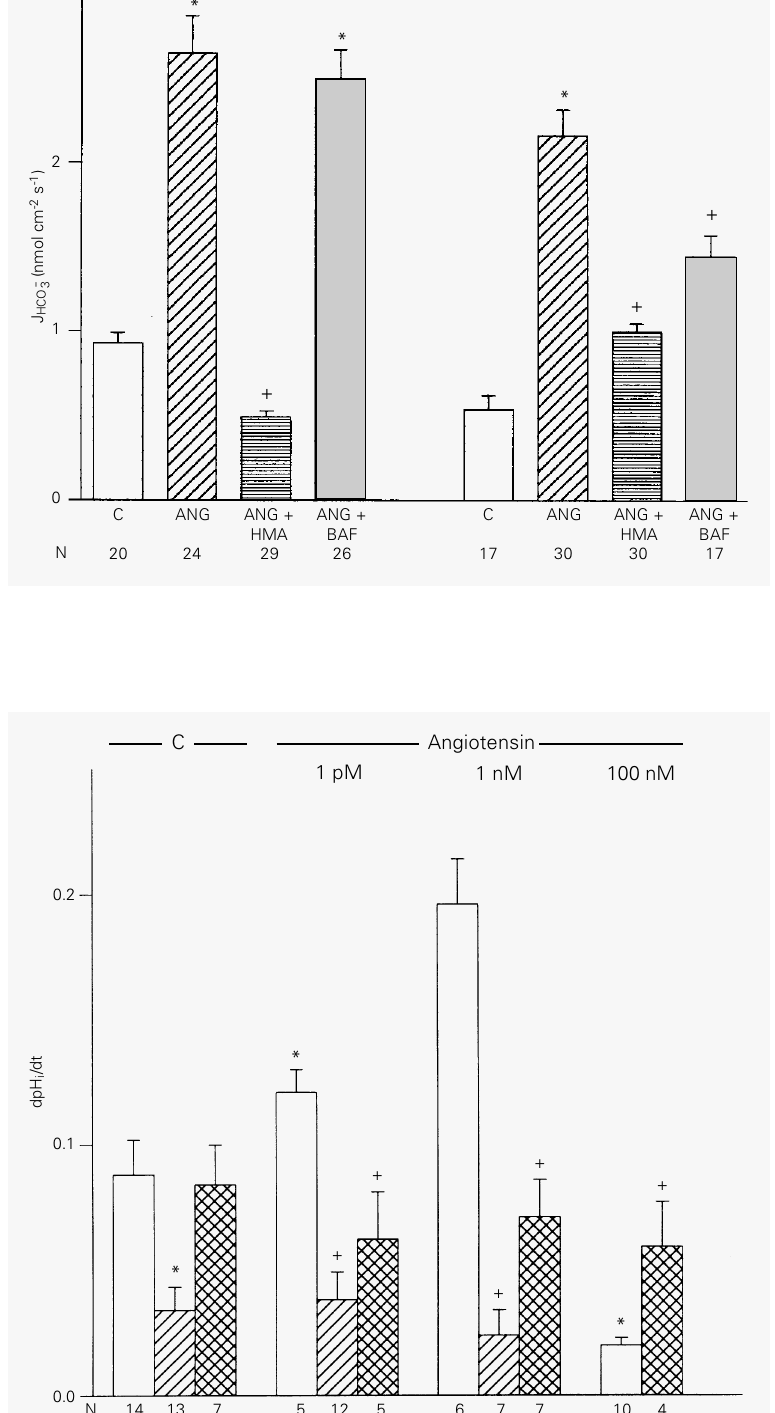
Figure 3 - Effect of luminal an- giotensin II (ANG, 1 pM) plus HMA (100 (cid:181)M) or bafilomycin A1 (BAF, 200 nM) on HCO 3- reab- sorption. The experiments were performed in early (left) and late (right) distal tubules. Data are re- ported as means – SEM. N, Number of microperfusions; J HCO3- , net HCO 3- reabsorption. *P<0.05 compared to control (C); + P<0.05 compared to ANG